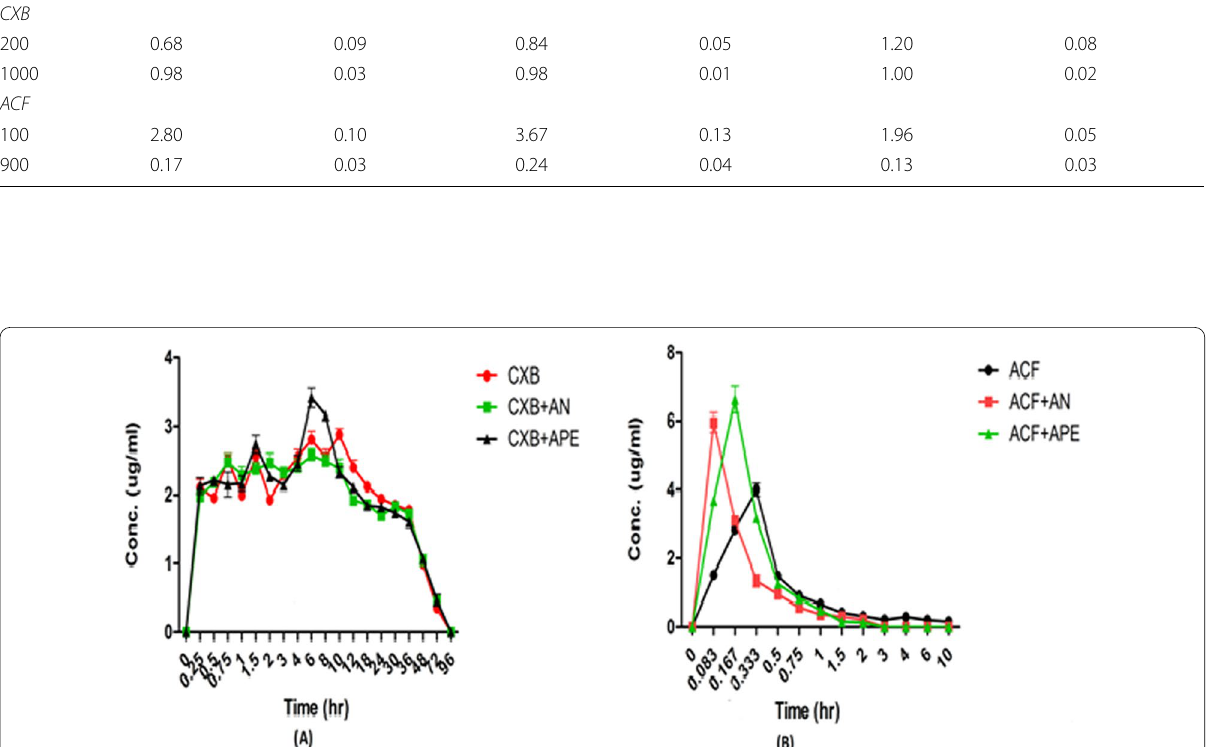
Table 4 Stability studies for the determination of CXB ( n Spiked conc. (ng mL − 1 )